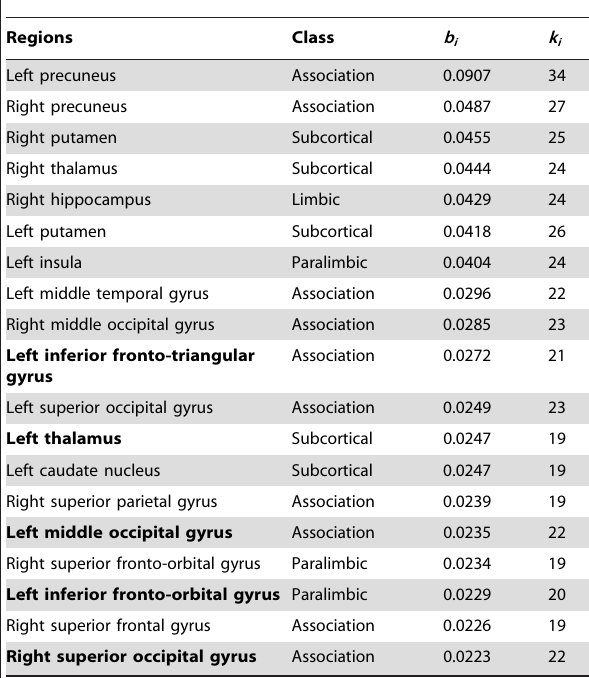
Table 4. Hub regions of the NC